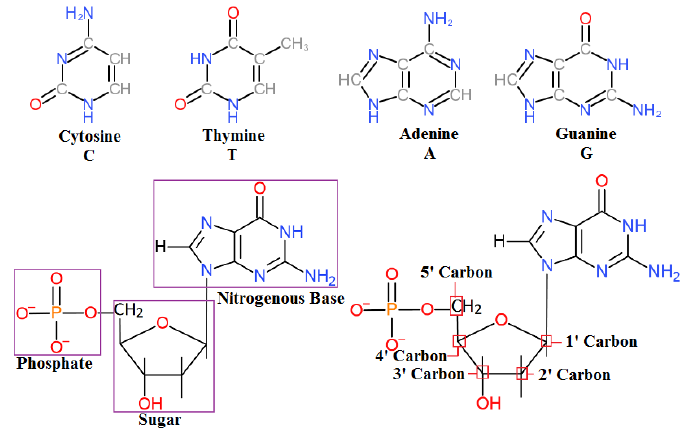
Figure 1. Four types of nitrogenous base and structure of a single nucleotide.